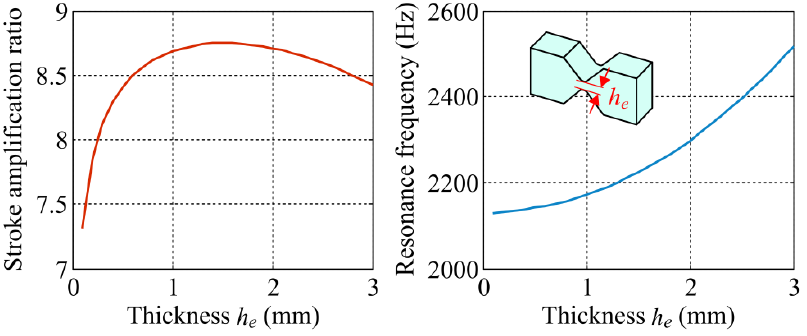
Figure 12. Theoretical results of the displacement amplification ratio and the main resonance fre- quency for the displacement amplification mechanism versus the minimum thickness of V-type flexure hinges.